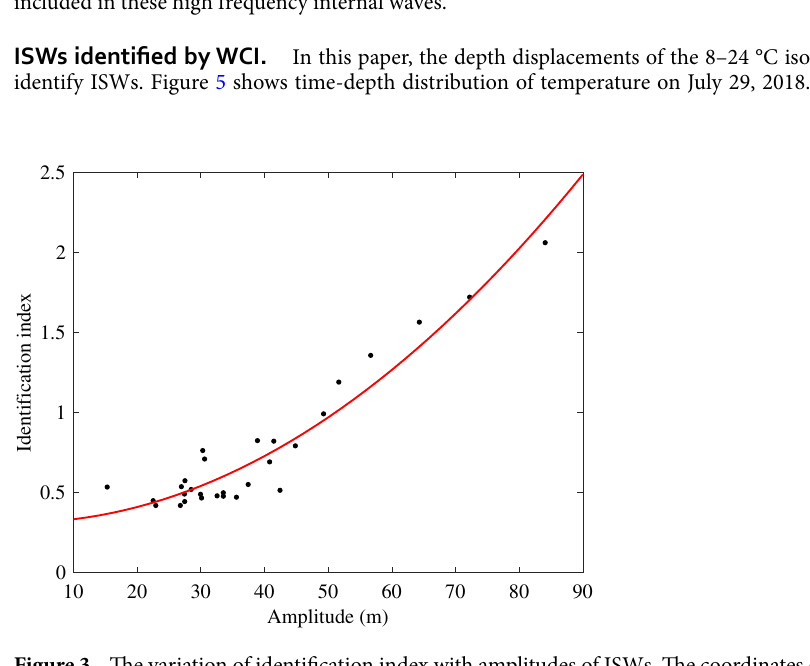
Figure 3. The variation of identification index with amplitudes of ISWs. The coordinates of x-axis of black points are the amplitudes A m of ISWs, while the coordinates of y-axis are the values corresponding to the ISWs in the T em . The red curve is the least-squares fitted curve of the black